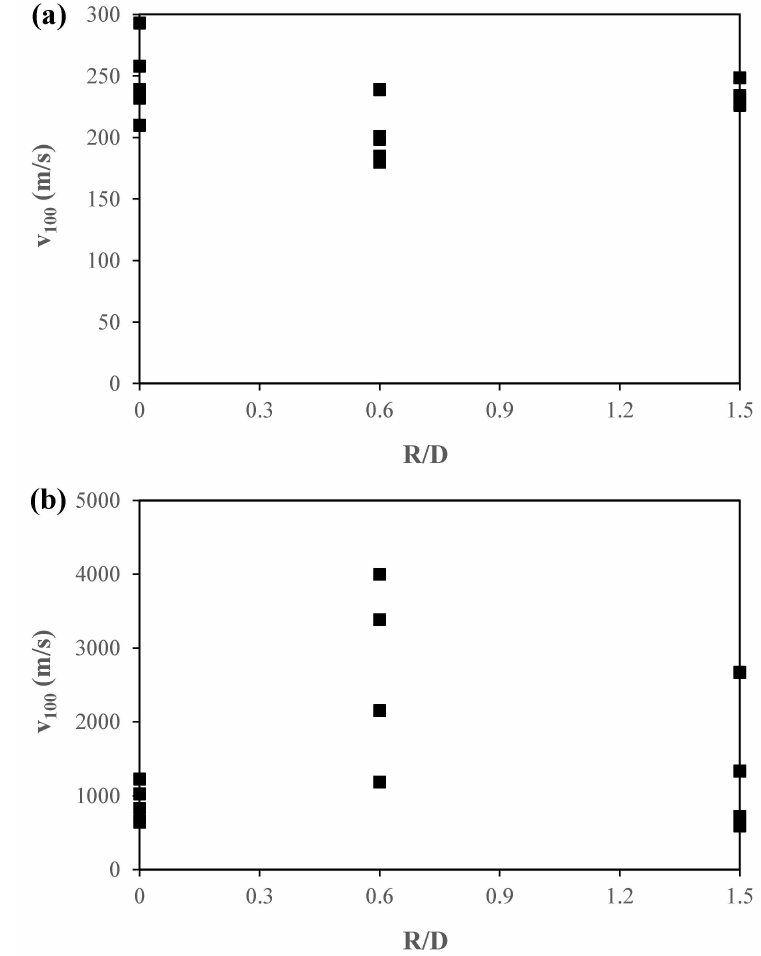
Figure 10. Influence of R/D ratio on pressure wave propagation for aluminium explosions along ducts: ( a ) Wave propagation speed between position 1 and 2, ( b ) Wave propagation speed between position 2 and